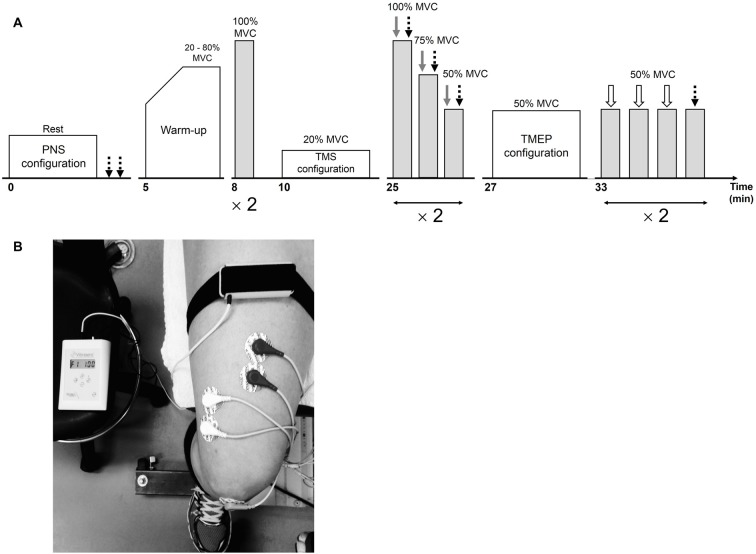
Overview of the neuromuscular testing protocol prior to the interventions (A). Following the interventions, the warm-up and stimulation configurations were not completed. Peripheral nerve stimulation (PNS), transcranial magnetic stimulation (TMS) and electrical stimulation over the thoracic spine are represented by dotted black, gray and white arrows, respectively. The position of the vibratory device on the leg during the 30-min vibration period is illustrated in (B).